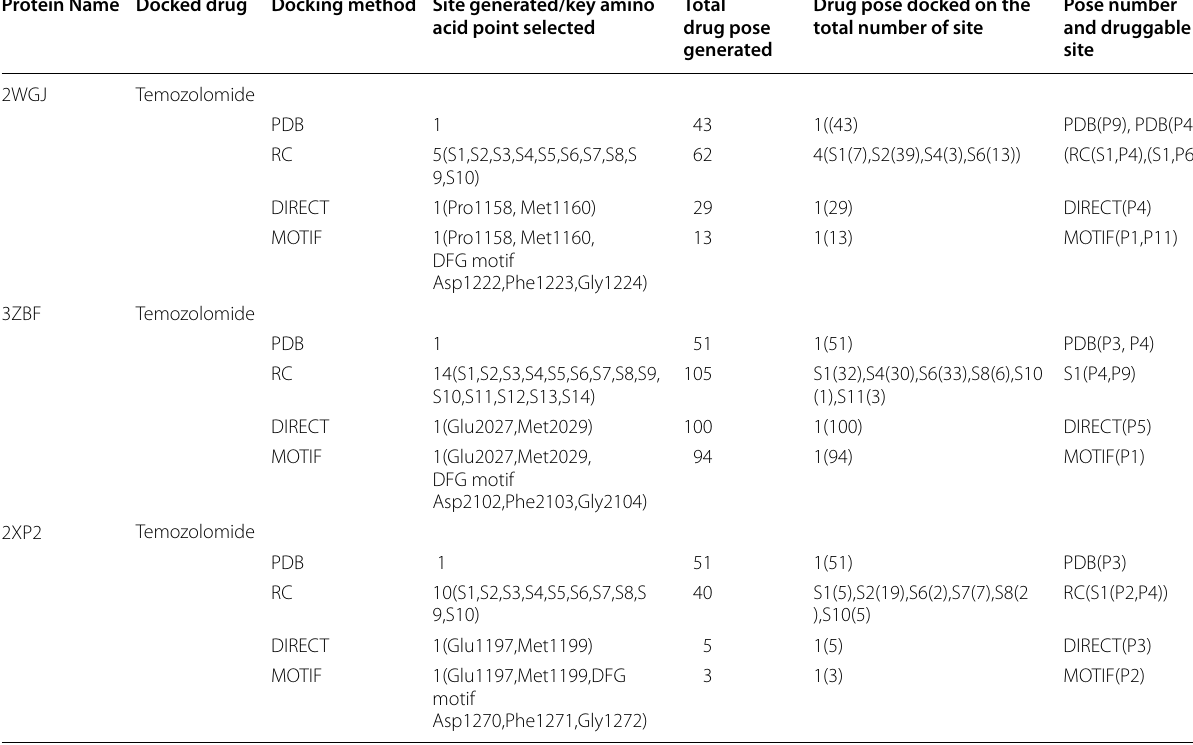
Table 3 Details of the docked drug, total drug pose generated in each docking method and details of the druggable binding site Protein Name Docked drug Docking method Site generated/key amino acid point selected